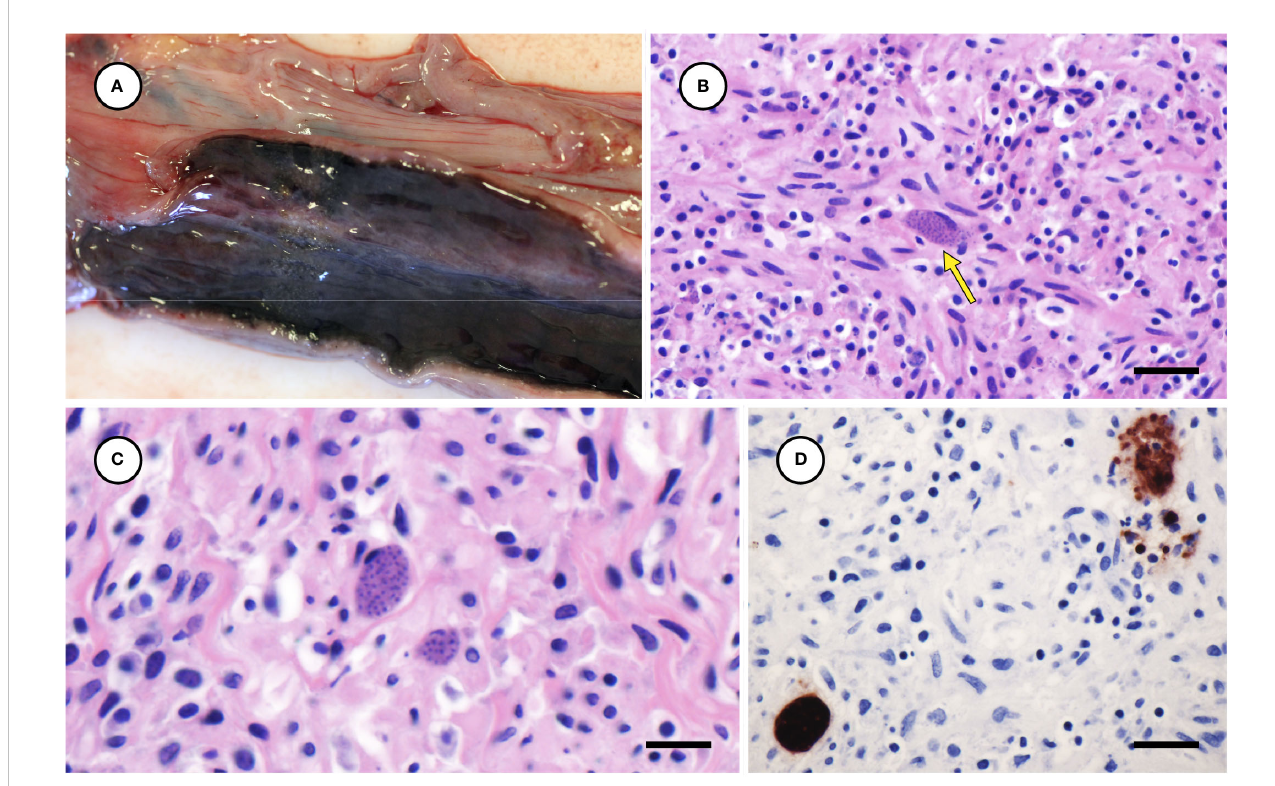
FIGURE 8 Mildly enlarged and congested left uterine horn from a sea otter with fatal toxoplasmosis and steatitis (A) . Low (B) and high (C) magni fi cation microscopic views of severely in fl amed uterine myometrium from the same otter with intralesional Toxoplasma gondii -like tissue cysts (indicated by arrow for B ) ( B, C : H&E stain, bar = 20 and 10 µm, respectively). Immunohistochemical stain of uterine myometrium from the same sea otter demonstrating strong positive immunostaining of intralesional protozoa for T. gondii (D) (Bar = 20